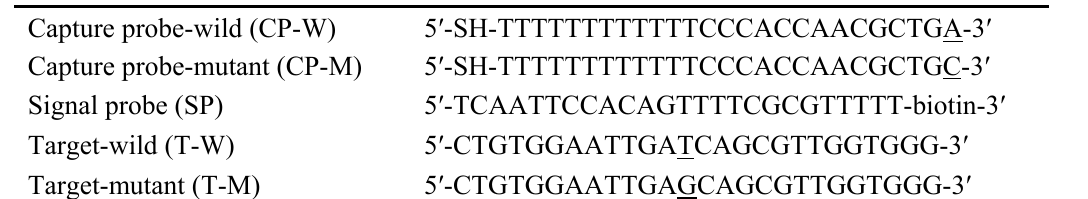
Table 1. Sequences of